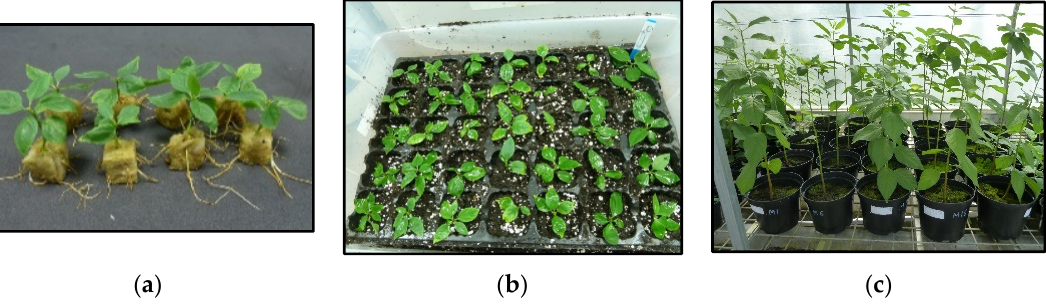
Figure 11. Shoots of CFN cultured in jars and RITA© with 3% sucrose and rooted in rockwool cubes. ( a ) Shoots proliferated in jars 6 weeks after auxin treatment and ( b , c ) plantlets from shoots proliferated in RITA© after being transferred to the phytotron ( b ) and 3 months later in the greenhouse ( c ).